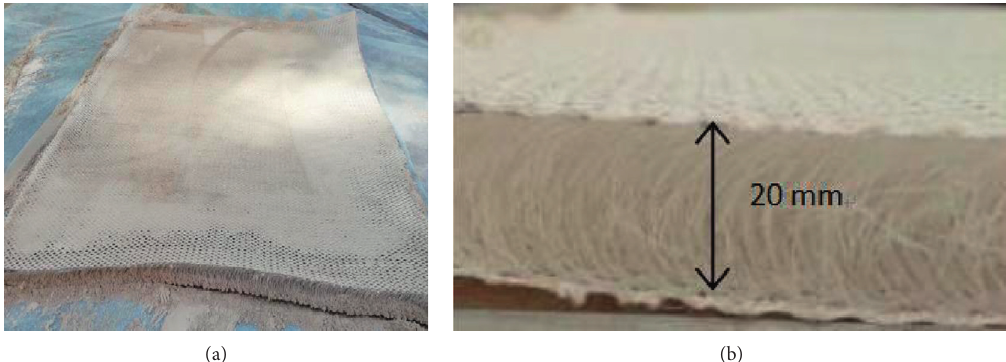
Figure 3: Schematic diagram of the concrete canvas. (a) Concrete canvas filled with cement powder. (b) The size of 3D cc.